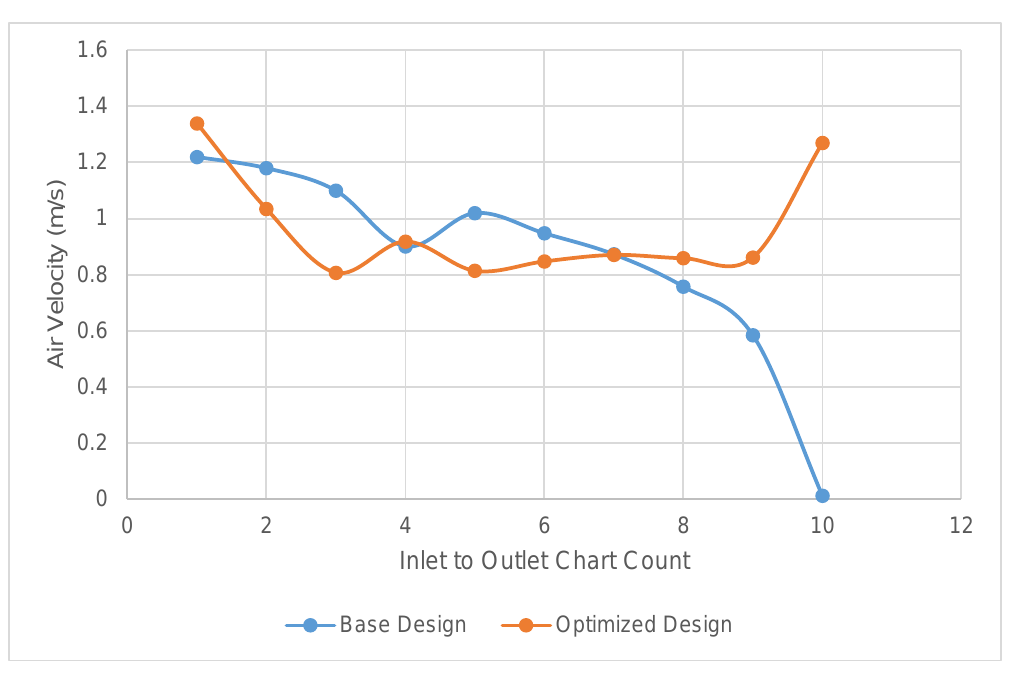
Figure 14. Comparison of both